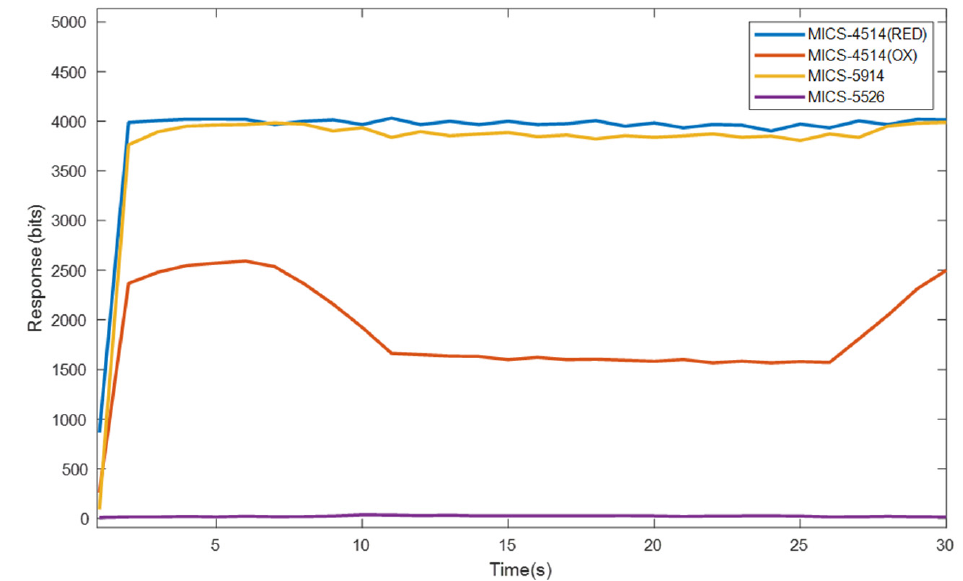
Figure 7. E-nose response to an ethanol sample.